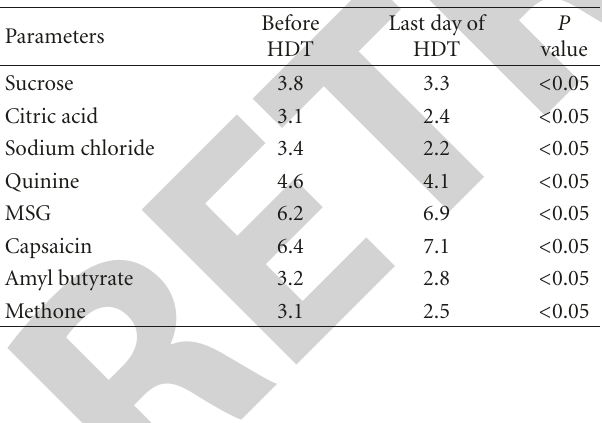
Table 2: The square means of the thresholds of all persons before and on last day of HDT in 10 healthy persons. The thresholds are reported as the dilution series values (dilution 10 is most conc., dilution 1 is least